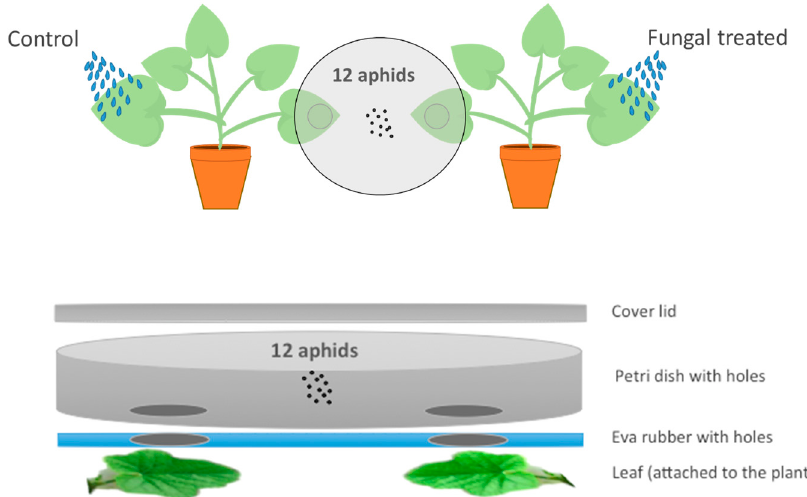
Figure 1. Design of an experimental arena for the choice bioassay. The set-up consists of one large Petri dish (150 mm × 15 mm) with two holes (diameter 25 mm each) in the bottom and covered by the lid. The area in contact with the plant was lined with eva rubber to avoid damaging the leaves. Aphids could choose between an unsprayed but endophytically-colonized leaf and a leaf from the control plant, or they could remain in the neutral area (no choice). The final position (endophytically-colonized leaf, control leaf, or neutral area) was